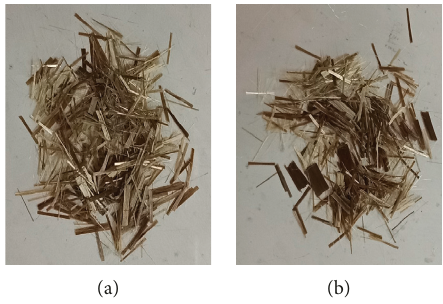
Figure 5: The appearance of basalt fiber after 200 ° C high tem- perature treatment. (a) Before 200 ° C high temperature treatment. (b) After 200 ° C high temperature